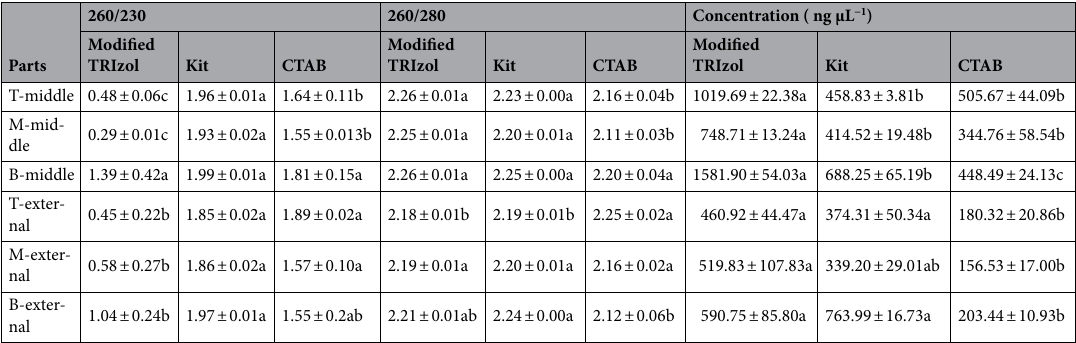
Table 3. Average purity and yield of total RNA extracted from middle and external scales of Lilium davidii var. unicolor using different methods. T The top part of the detected scales, M The middle part of the detected scales, B The basal part of the detected